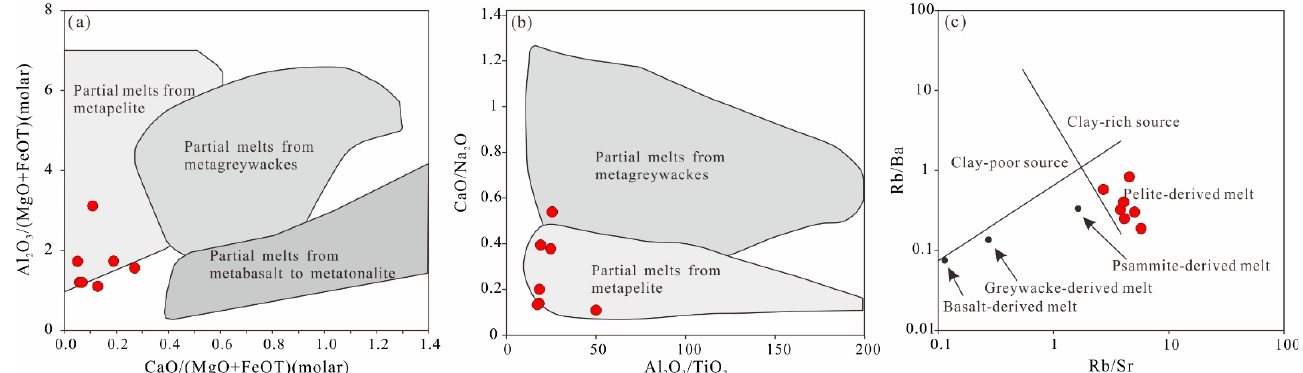
Figure 11. Magma source discrimination diagrams of Madeng dacite. ( a ) CaO/(MgO + FeO T ) vs. Al 2 O 3 /(MgO + FeO T ) [57]; ( b ) Al 2 O 3 /TiO 2 vs. CaO/Na 2 O [55]; ( c ) Rb/Sr vs. Rb/Ba [58].